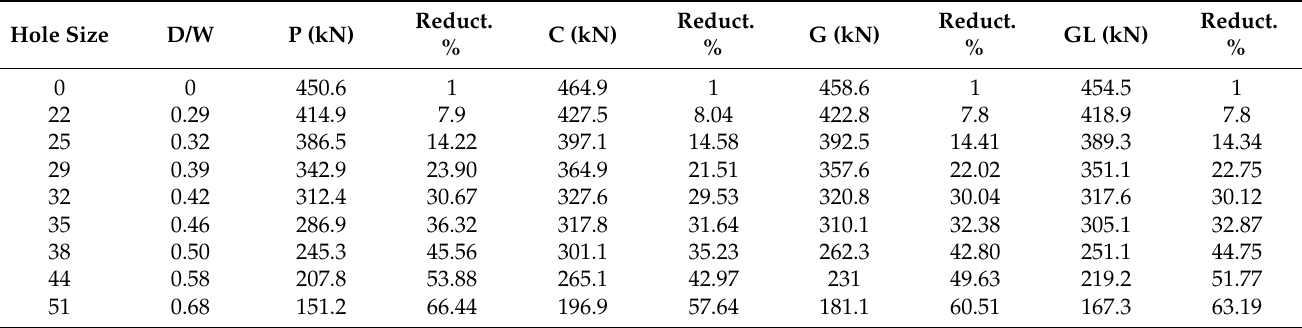
Table 3. Results of the specimens with different hole